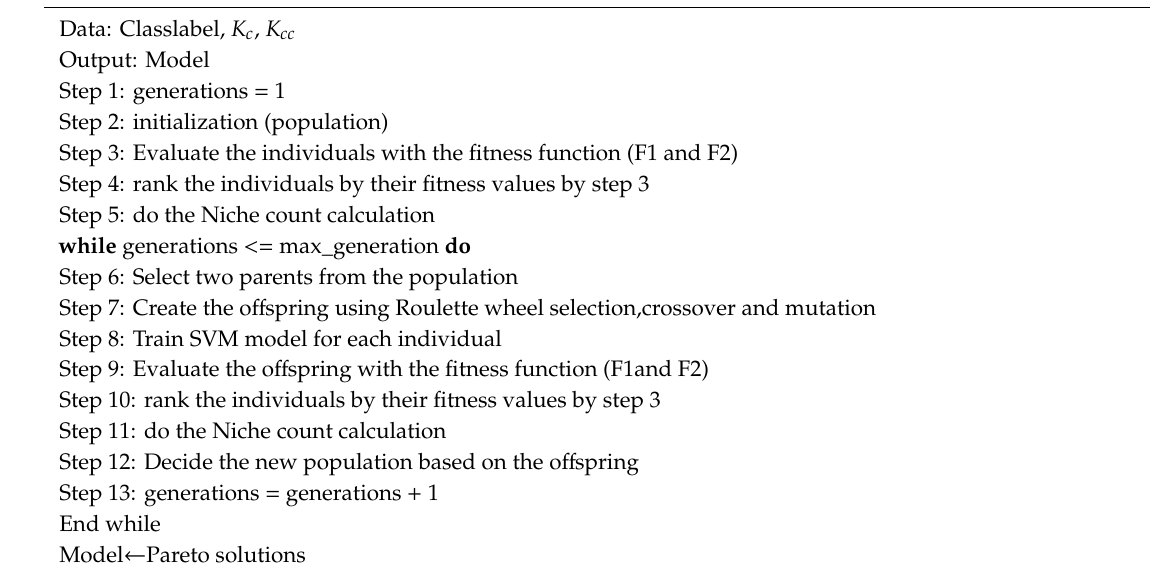
Algorithm 2 TrainClassifier ( Classlabel , K c , K cc